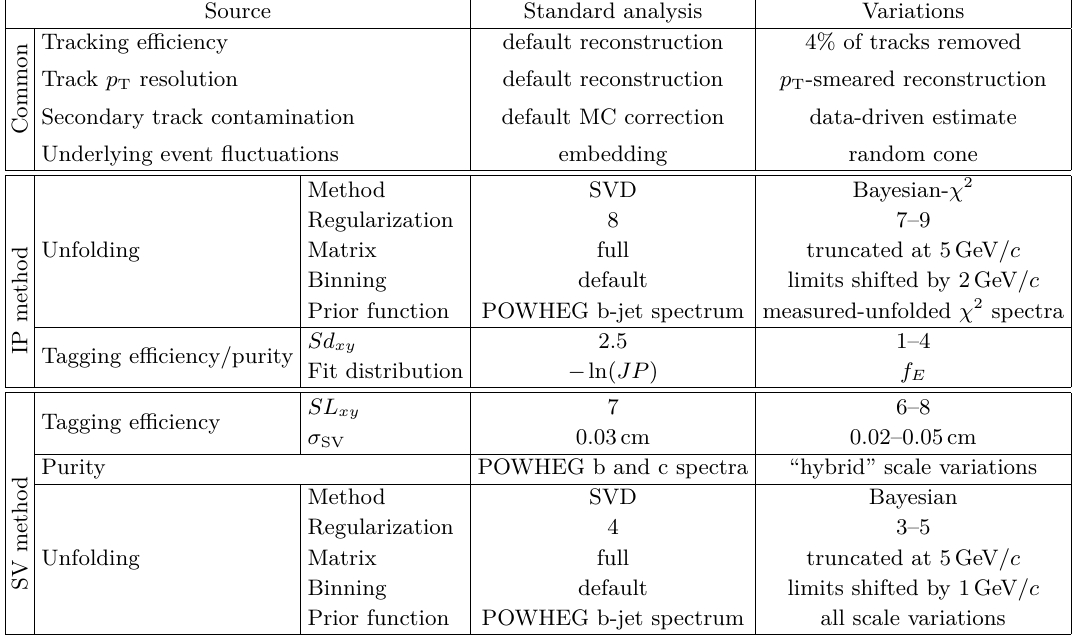
Table 1. Summary of sources of systematic uncertainty and adopted variations to estimate their effects in the cases of the SV and the IP